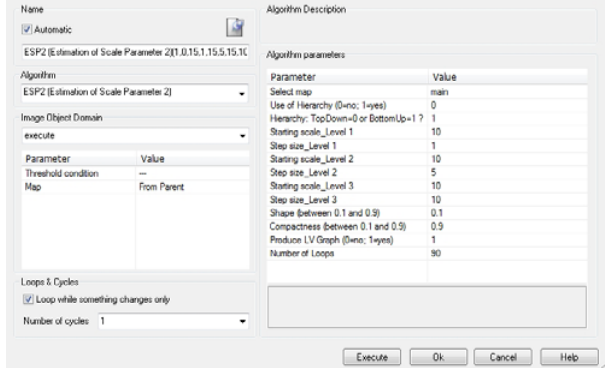
Figure 4. The graphical user interface of ESP2. The setting values used in the tests are described for different